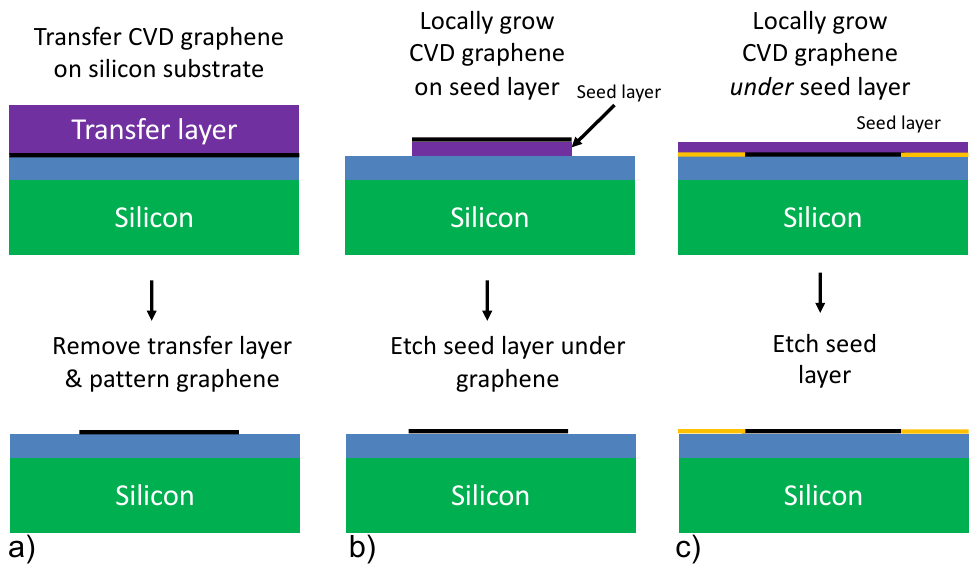
Figure 1. Schematic flows for transfer-based and transfer-free integration of CVD graphene on silicon wafers. ( a ) Transfer-based integration flow. ( b ) Transfer-free integration flow, growing graphene locally on top of a seed layer (purple). ( c ) The focus of this work: transfer-free integration flow growing graphene under a seed layer, where the yellow blocking structure layer is used to define the local graphene growth region. The blue layer in the figure can be the CMOS backend SiO 2 layer, or any other interface of